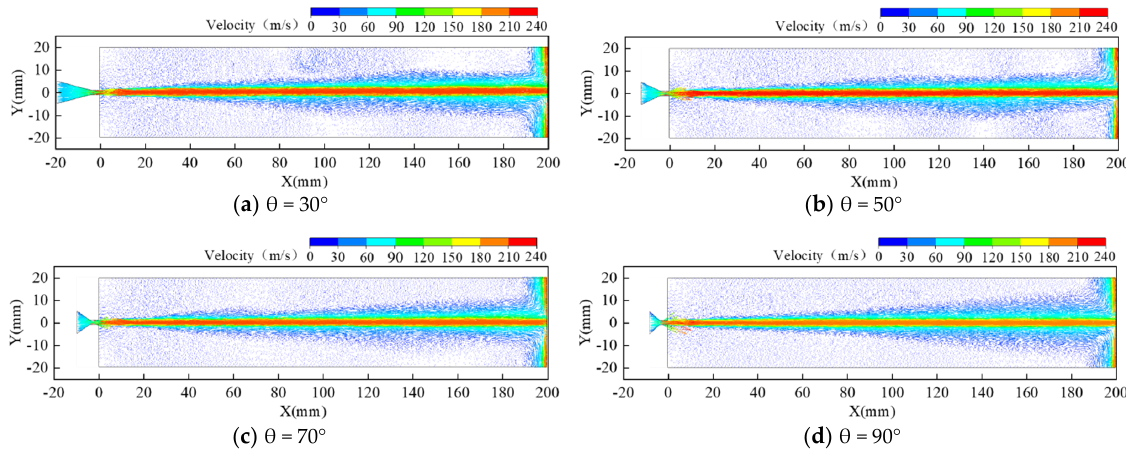
Figure 11. Velocity vector of the flow field when t = 0.8 ms.